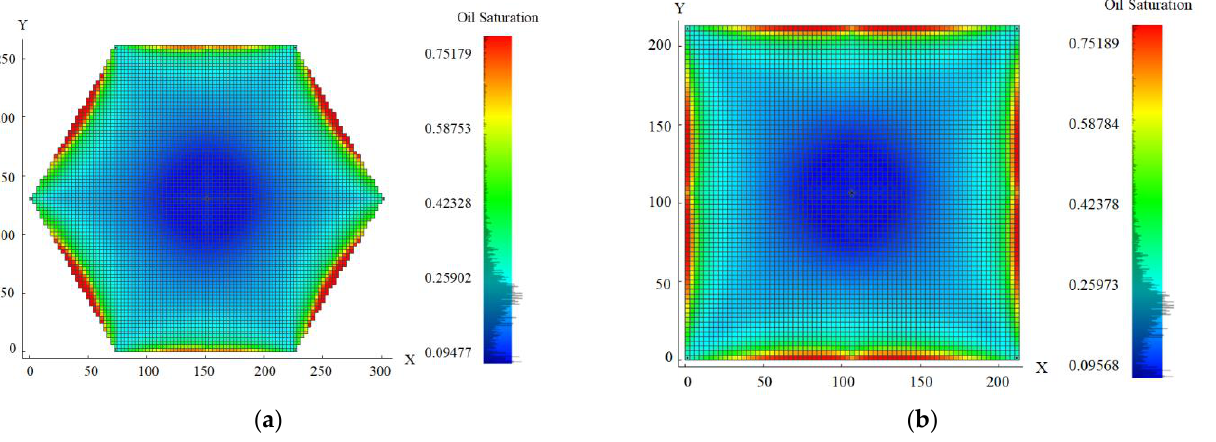
Figure 5. The distribution of swept intensity. ( a ) Inverted seven-spot well pattern; ( b ) five-spot well pattern.